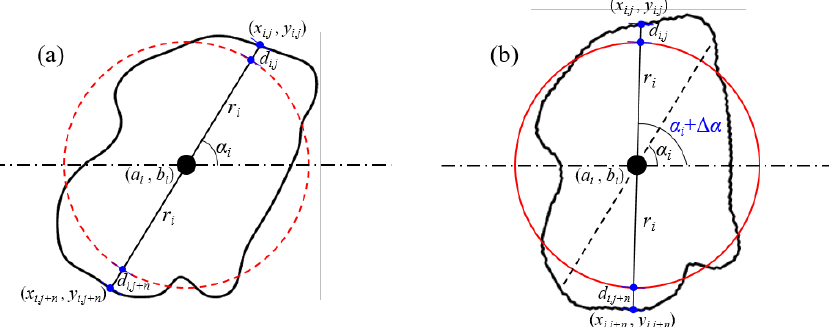
Figure 10. The principle of grain orientation change. ( a ) Original relationship between grain boundary and mapping circle. ( b ) The relationship between them under a Δα i counterclockwise rotation.